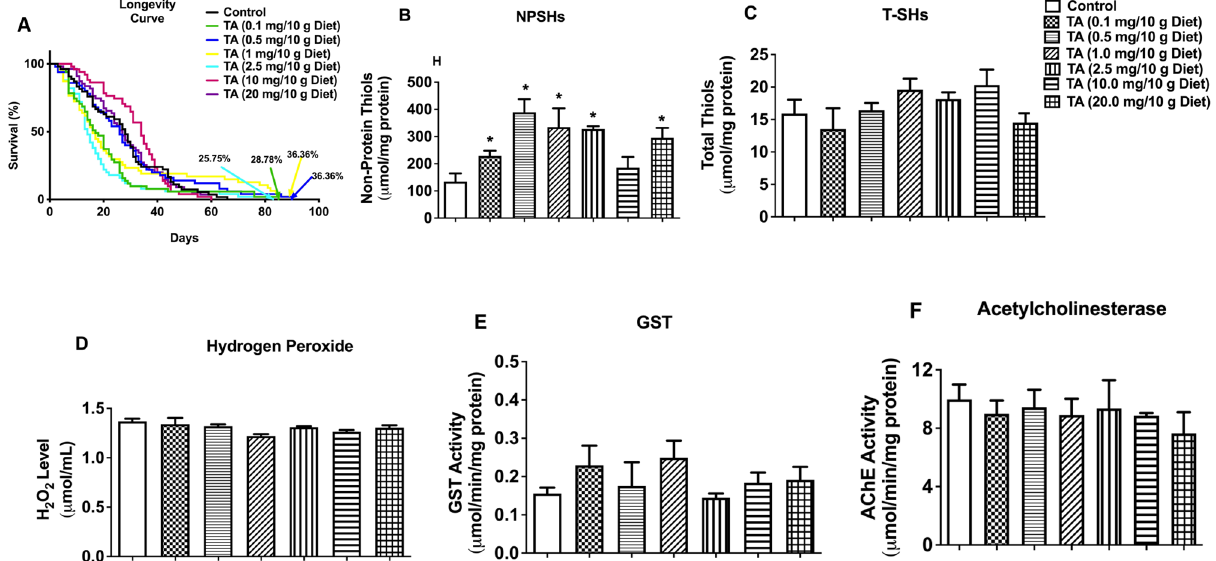
Figure 1. Effects of TA (0.1, 0.5, 1.0, 2.5, 10, and 20 mg/ 10 g diet) on longevity ( A ), levels of NPSHs ( B ), T-SHs ( C ) and H 2 O 2 ( D ), and activities of the enzymes GST ( E ) and AChE ( F ) in D. melanogaster . Data in ( B – F ) are presented as mean ± SEM of 50 flies per vial (five replicates per group). *Significant difference compared with control group (p < 0.05). TA trans-astaxanthin, NPSHs non-protein thiols, T-SHs total thiols, GST glutathione- S - transferase, AChE